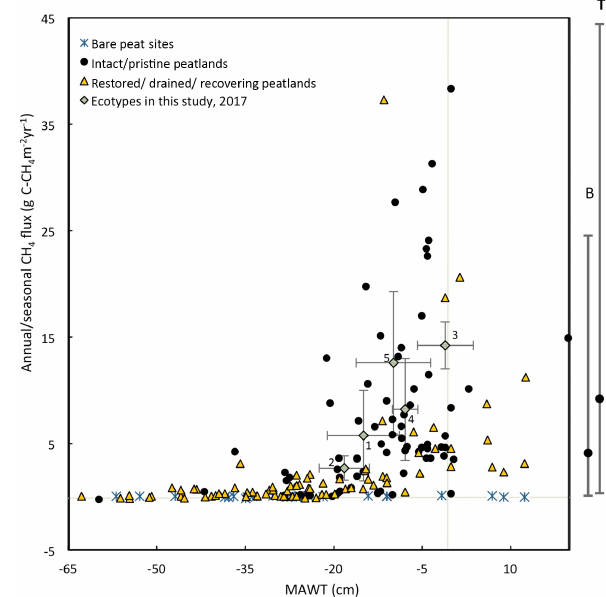
Figure 11. Mean annual water table vs. the annual NEE for the five ecotypes in this study (error bars are standard deviation) com- pared to global studies from boreal and temperate peatlands. (Data are from Wilson et al., 2015, 2016b; Vanselow-Algan et al., 2015; Tuittila et al., 1999; Waddington et al., 2010; Strack et al., 2014; Nilsson et al., 2008; Dinsmore et al., 2010; Koehler et al., 2011; Chimner et al., 2017; Gažoviˇc et al., 2013; Lund et al., 2012; Levy and Grey, 2015; McVeigh et al., 2014; Helfter et al., 2015; Peichl et al., 2014; Strachan et al., 2016; Roulet et al., 2007; Wadding- ton and Roulet, 2000; for more details and additional studies see Table S9). Also, shown to the right of the figure is the mean and 95% CI NEE from nutrient-poor, wet (MAWT > − 30cm) boreal (B) and temperate (T) peatlands (from the review paper Wilson et al., 2016a). Numbers indicate the ecotype with Sphagnum cutover as 1, Calluna cutover as 2, Eriophorum cutover as 3, submarginal as 4, and subcentral as 5.